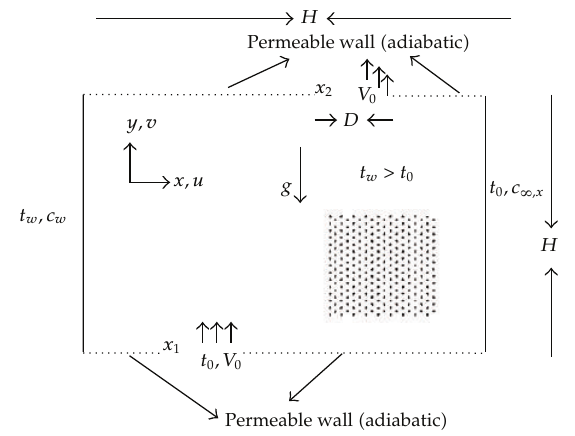
Figure 2: Schematic diagram of the porous enclosure with prescribed boundary